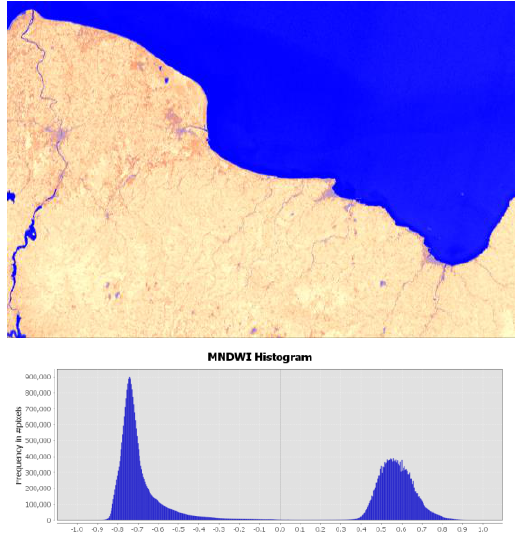
Figure 10. MNDWI image (above) of DS4 and its histogram (below).